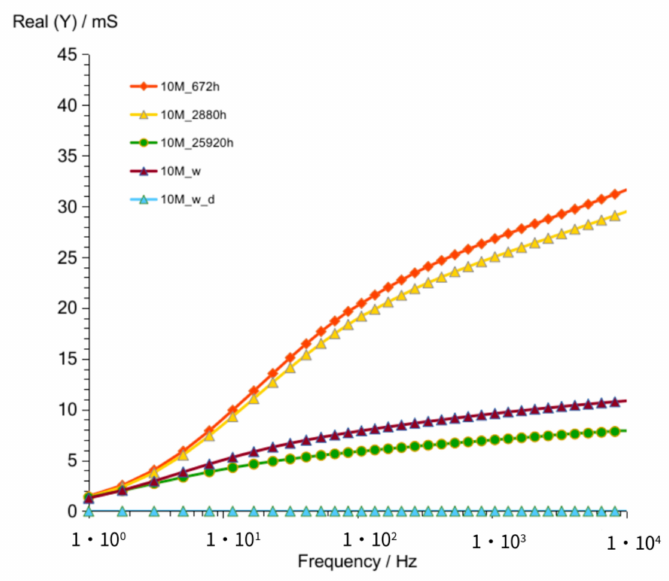
Figure 9. Admittance of G10M geopolymer concrete taken after 672 to 25,920 h from starting